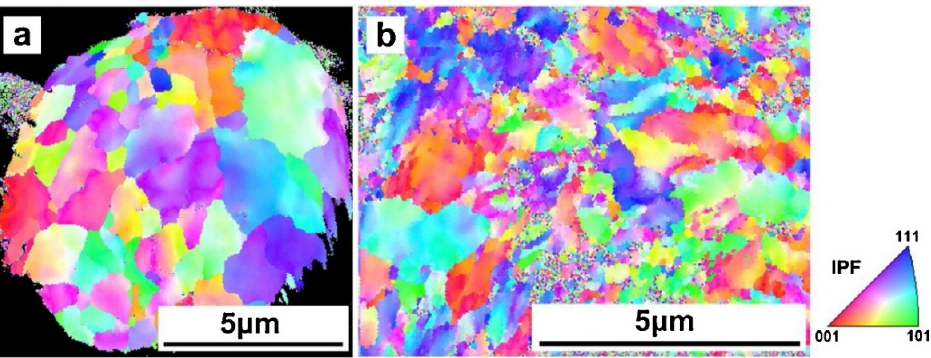
Figure 3. EBSD IPF maps of ( a ) a single HEA particle and ( b ) the HEA coating prepared by CS